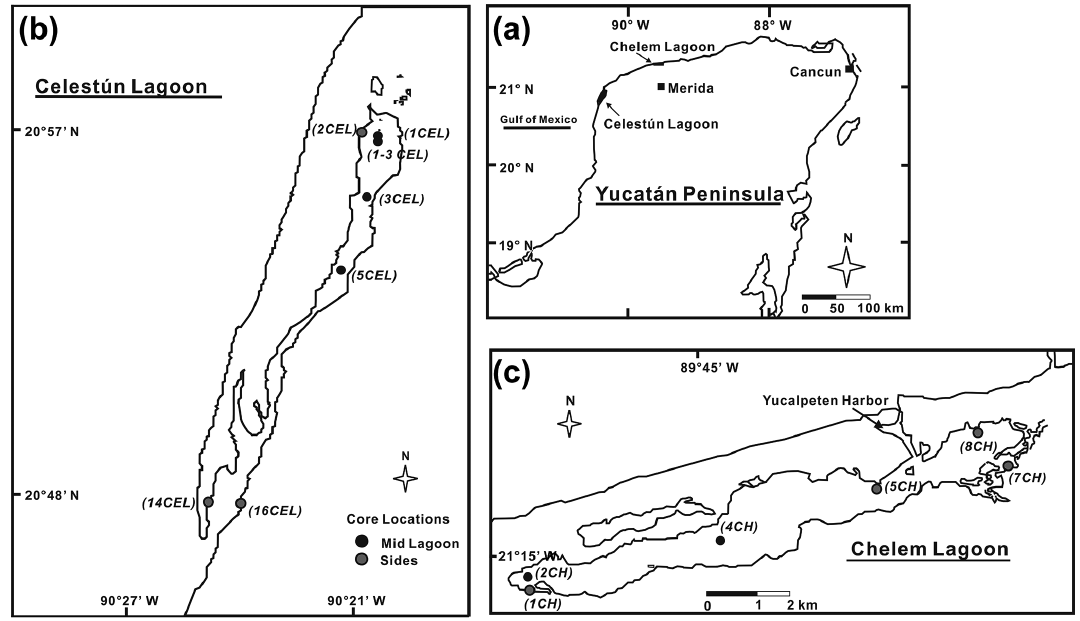
Figure 1. Maps of (a) the Yucatán Peninsula with lagoon locations, (b) Celestún Lagoon and (c) Chelem Lagoon showing the sampling stations (circles) of sediment